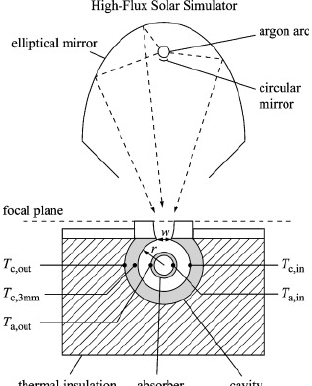
Figure 7. Scheme of the receiver/reactor designed by Melchior et al. Reprinted from [25] with permission from